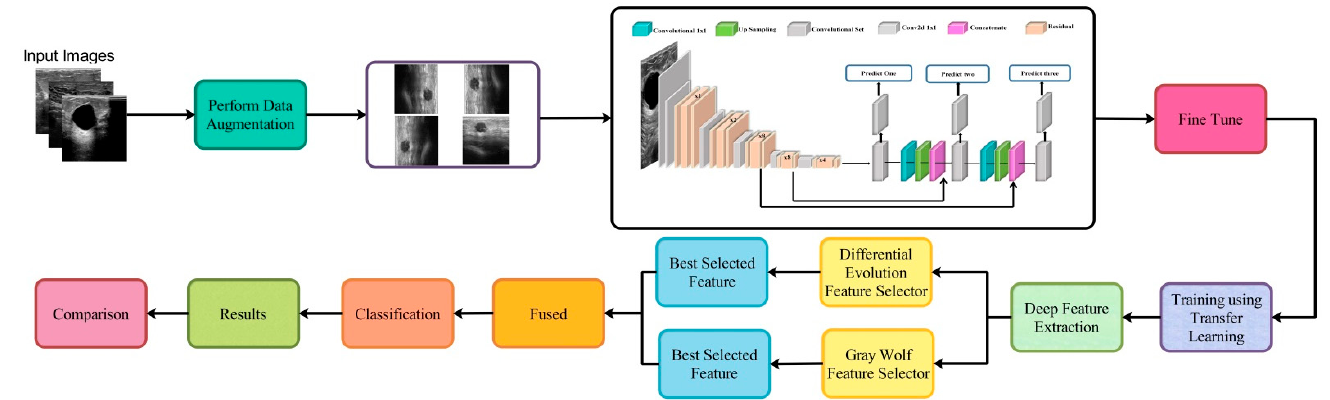
Figure 1. The proposed framework for breast cancer classification using Ultrasound Images.